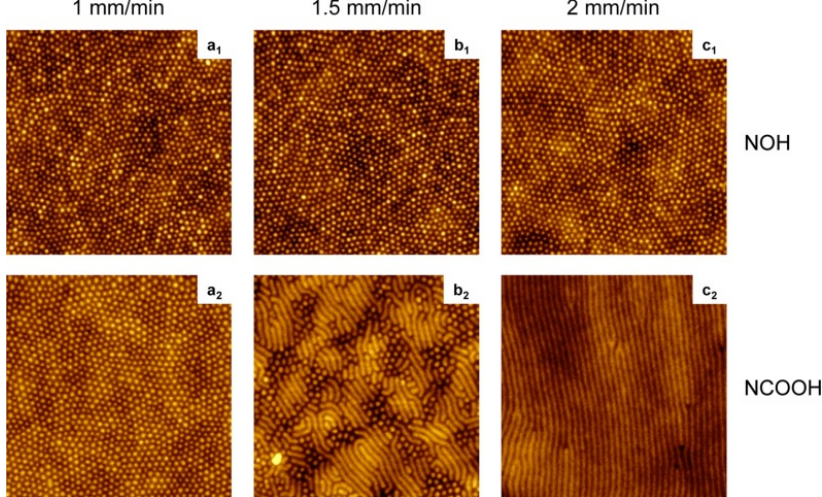
Figure 5. AFM images (2 × 2 μ m 2 , z = 10 nm) of poly(styrene-block-4-vinylpyridine) (PS-P4VP) diblock copolymer films dip-coated at the rates indicated from tetrahydrofuran (THF) solutions containing SM = NOH or NCOOH at equimolar SM/VP ratios. Reprinted with permission from reference [101]. Copyright 2012 American Chemical Society.